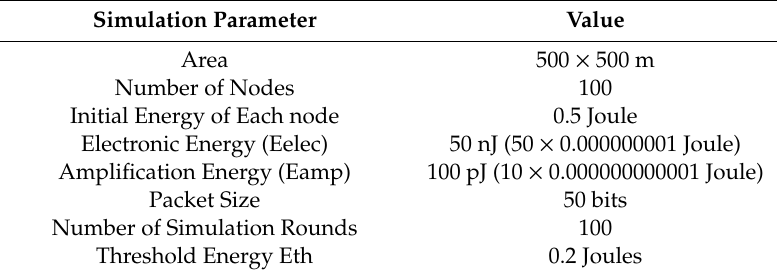
Table 8. Simulation